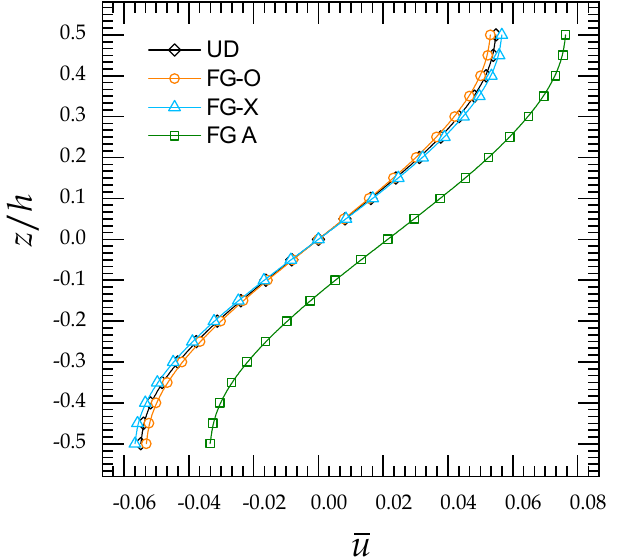
Figure 14. Dimensionless in-plane displacement u through the thickness of simply supported GRNC plate for various GPLs reinforcement patterns (g (cid:2891)(cid:2900)(cid:2896)∗ = 1%) .